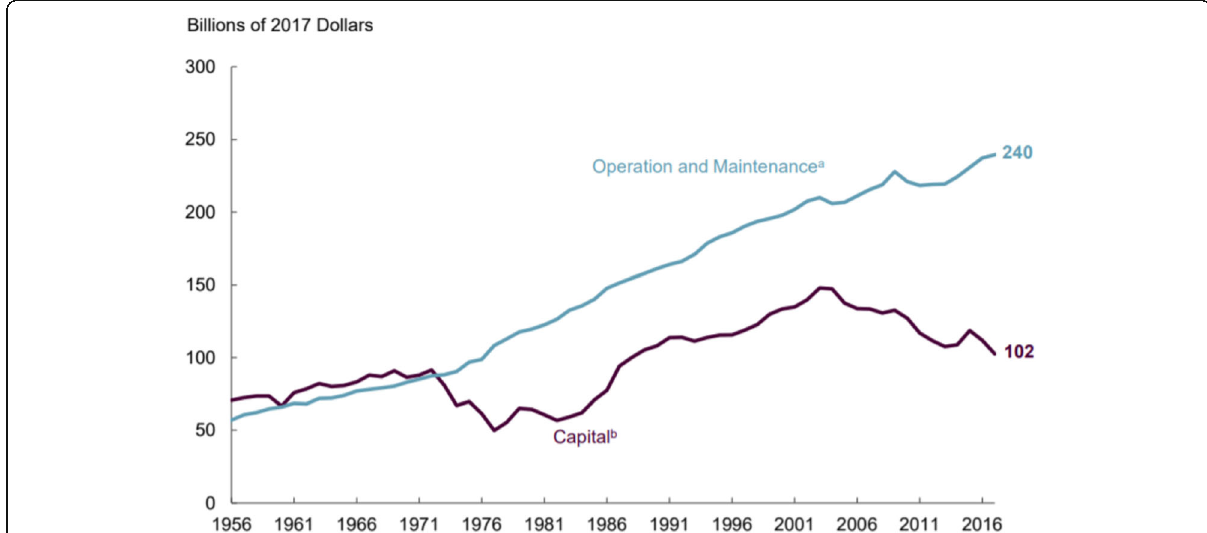
Fig. 1 State and Local Spending on Transportation and Water Infrastructure, by Category of Spending, 1956 to 2017 [10] p.16. a Dollar amounts are adjusted to remove the effects of inflation using price indexes for government spending that measure the prices of goods and services consumed by governments, including materials and other inputs used to operate and maintain transportation and water infrastructure. b Dollar amounts are adjusted to remove the effects of inflation using price indexes for government spending that measure the prices of materials